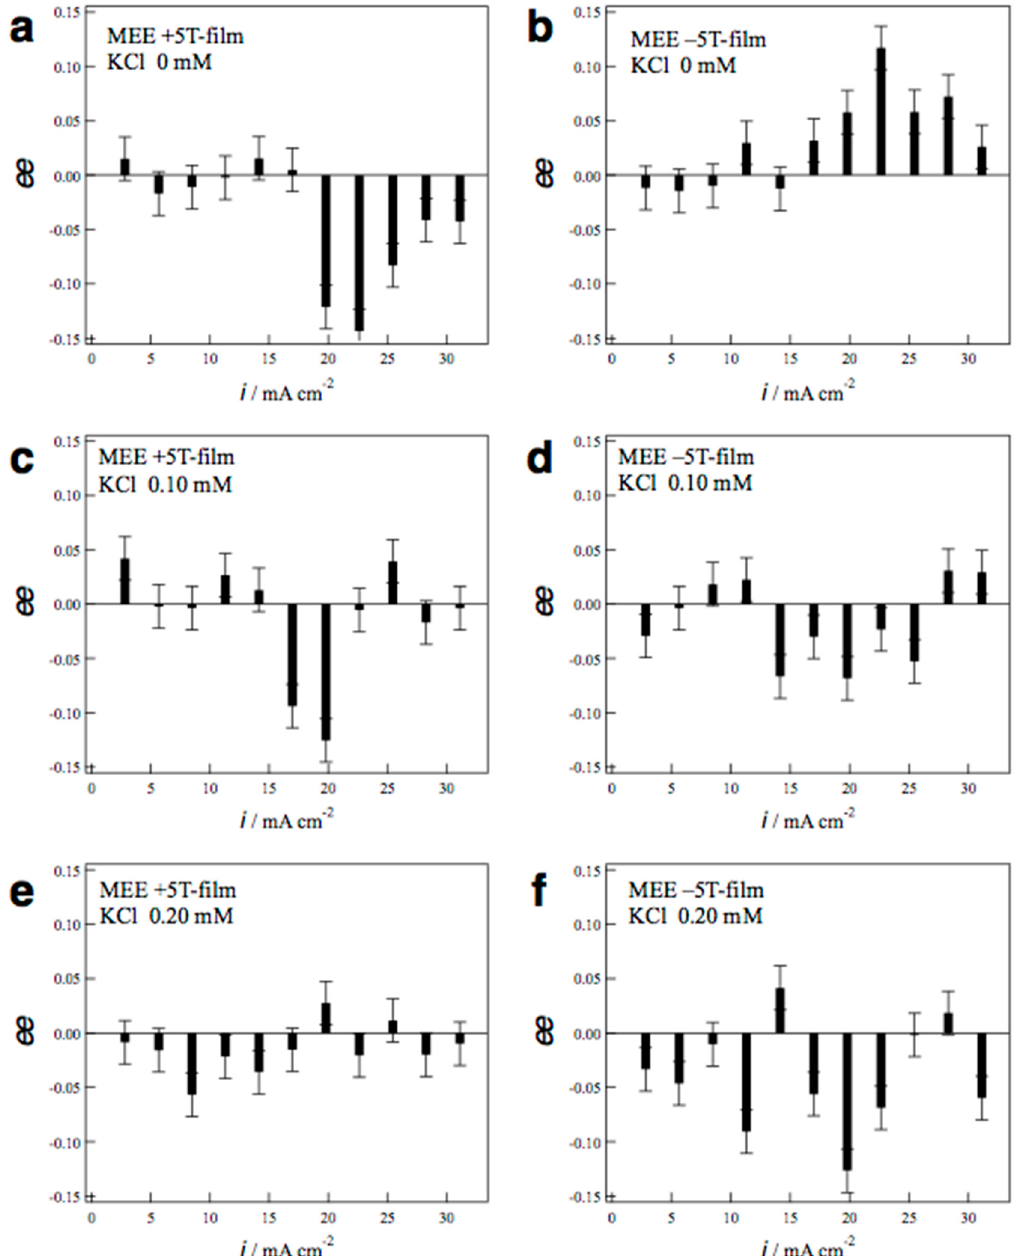
Figure 4. The ee ratio profiles of the MEE films versus the deposition currents. ( a ) +5T-film prepared without KCL; ( b ) − 5T-film without KCl; ( c ) +5T-film with 0.10 mM KCl; ( d ) − 5T-film with 0.10 mM KCl; ( e ) +5T-film with 0.20 mM KCl; and ( f ) − 5T-film with 0.20 mM KCl. The error bars reflect the values of multiple experiments for each condition.